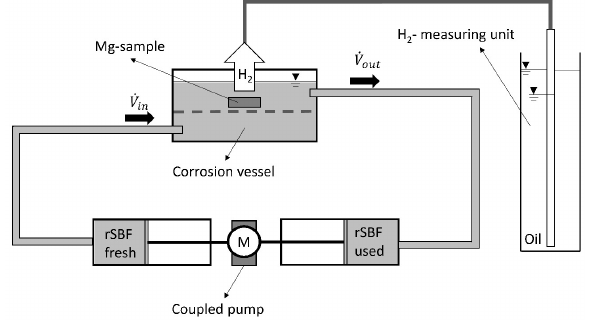
Figure 2. Experimental setup for measuring magnesium corrosion. The sample was placed in the corrosion vessel perfused with a continuous fluid flow. A coupled pump provided the fluid flow, transporting equal volumes of fluid in and out. The amount of hydrogen is determined using the H 2 measuring unit. The level difference between the outer glass cylinder filled with oil and the inner glass pipette filled with the H 2 gas was